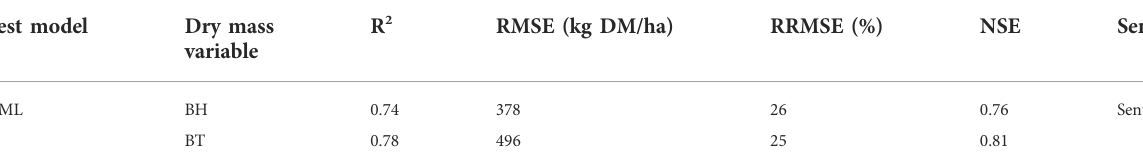
TABLE 4 Best model and sensor for estimating dry season herbaceous dry mass (BH) and total ecosystem foliage dry mass (BT) in the silvopastoral zone in Senegal.